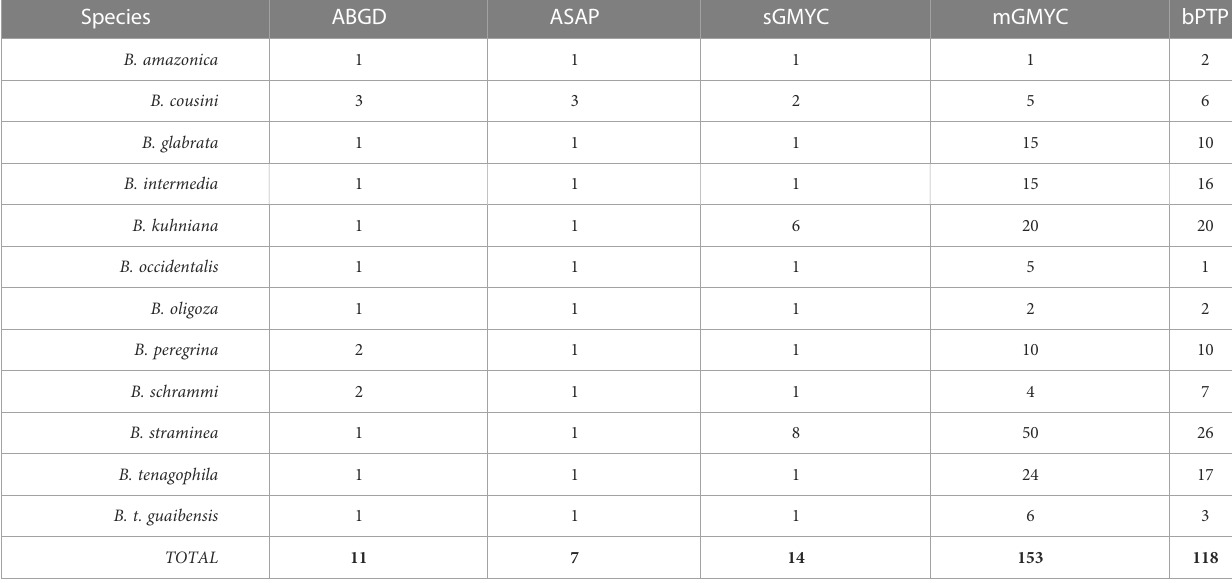
Tablewiththenumberofclustersgeneratedbythespeciesdelimitationalgorithmsusedinthisstudy.Thetableshowstheabsolutenumberofclustersbyspeciesandoverallfortheentiredataset of 223